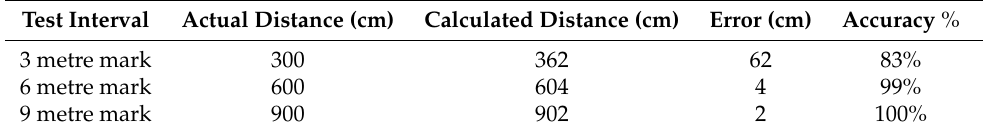
Table 2. Results for a test vehicle with a width of 155 cm.